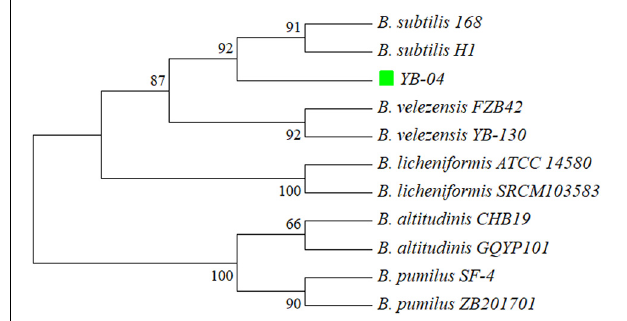
FIGURE 5 | Phylogenetic tree of B. subtilis YB-04 and 10 other Bacillus species based on 16S rRNA